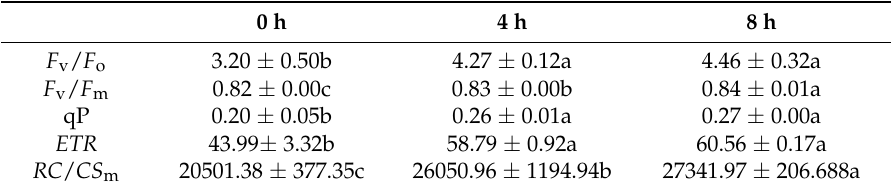
Table 1. PSII potential photochemical activities ( F v / F o ), PSII photochemical efficiency ( F v / F m ), photochemical quenching (qP), electron transport rate (ETR), and the number of reactive centers per unit area ( RC / CS m ) in leaves of mulberry seedlings exposure to 4 μL·L −1 NO 2 for 0 h, 4 h (4 h·d −1 , for one day), and 8 h (4 h·d −1 , for 2 days). Date represent means of four plants ± standard deviations. Different lowercase letters for the same parameter indicate significant differences among different treatments at p < 0.05 levels.